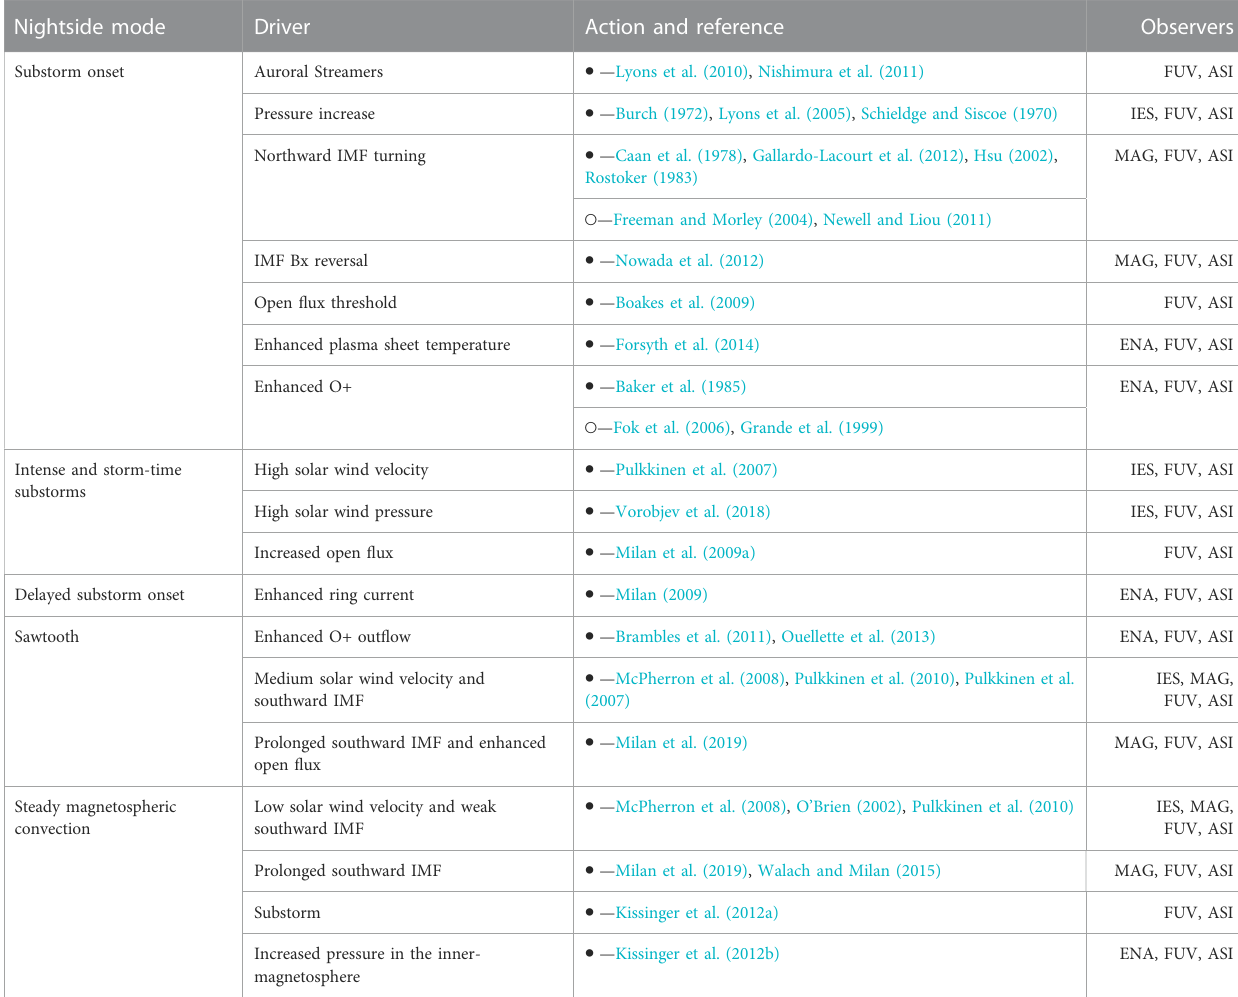
(cid:129) — TABLE 1 A synthesis of triggers for nightside response modes, trigger, ○ — does not trigger. The large number and variety of proposed drivers for nightside responsemodes demonstratetheneedfor STORM which images the global solar wind-magnetosphere interactionandwilldetermine theconditionsunderwhich these modes